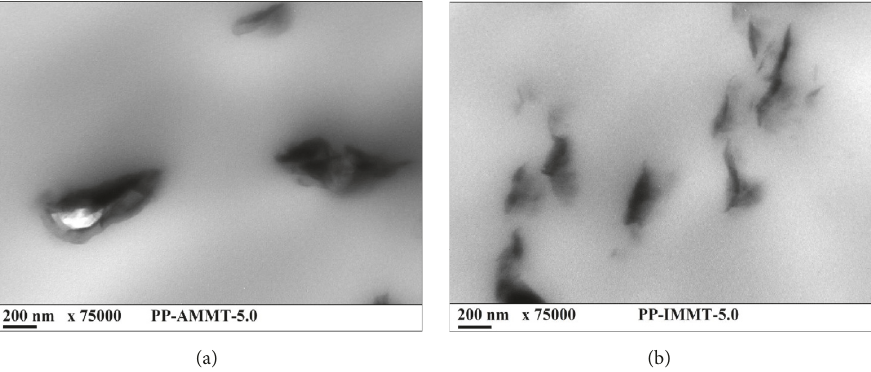
Figure 6: (a) TEM image of PP-AMMT composite. (b) TEM image of PP-IMMT composite.